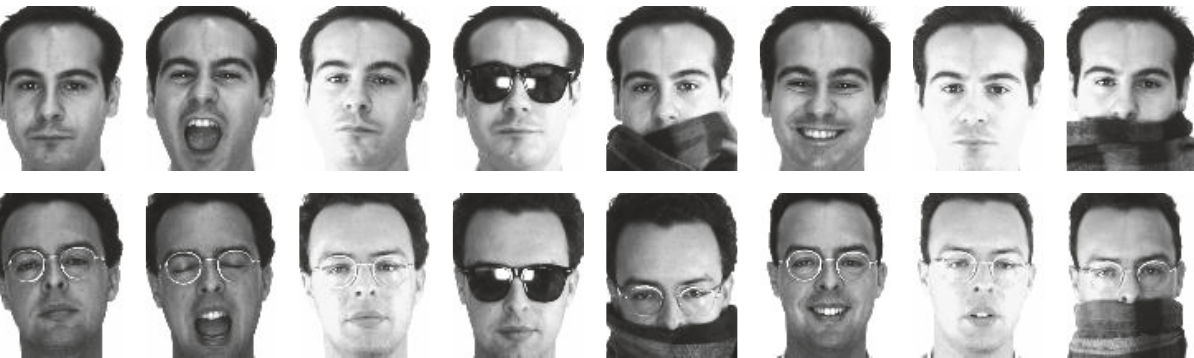
Figure 4: Some face images from the AR face database.